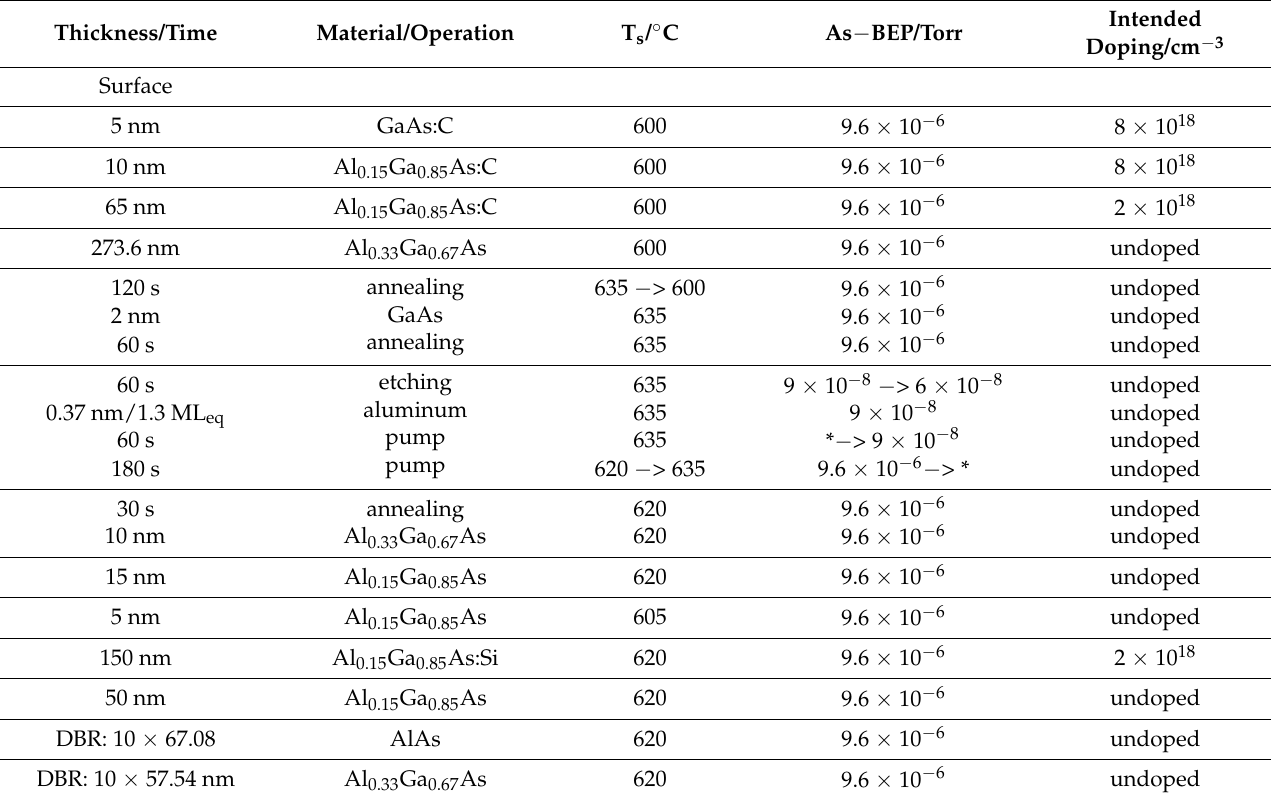
Table A1. The grown layer structure with relevant breaks, substrate temperature, arsenic beam equivalent pressure (As-BEP), and intended doping concentration. * points to the step